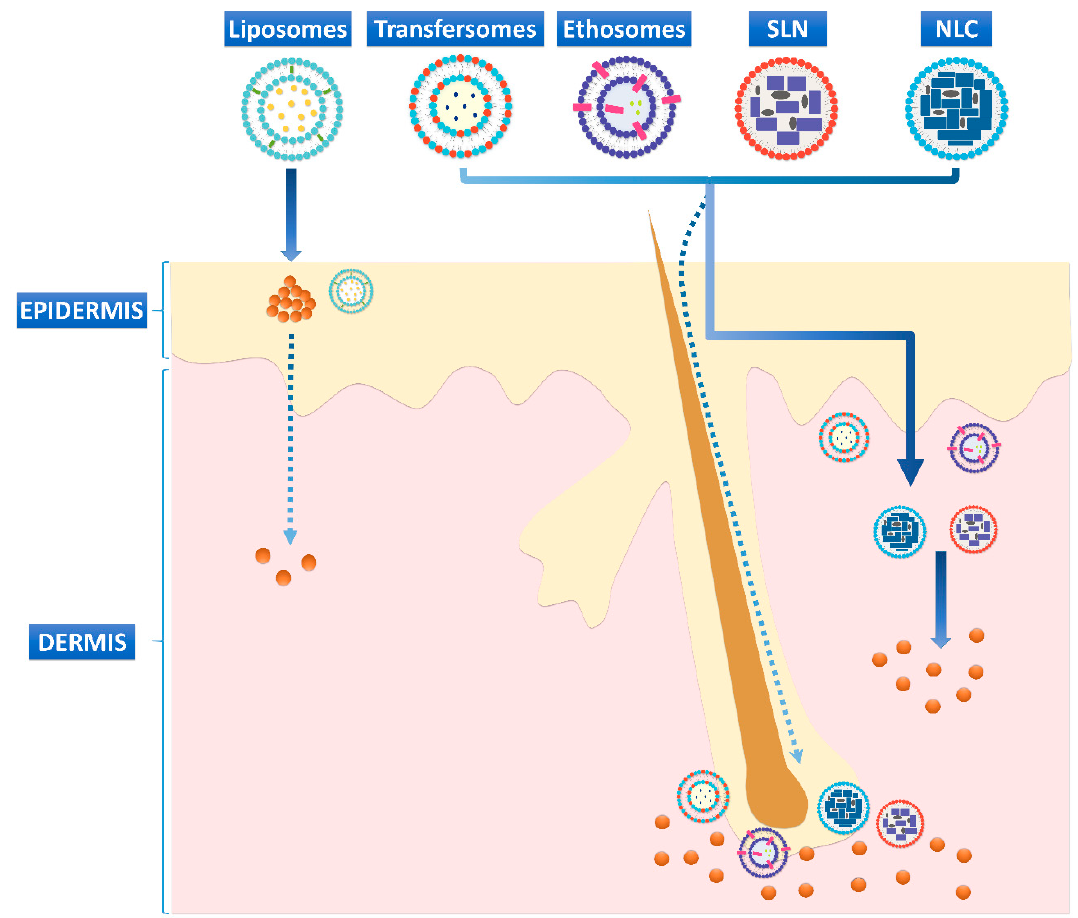
Figure 3. Schematic illustration of the anatomical target sites and skin penetration pathways of the nanosized-lipid-based drug delivery systems. Liposomes penetrate as an intracellular delivery system and deposit the drugs into the stratum corneum. They have poor penetration of the drug into the dermis. Transfersomes squeeze through the intercellular parts of the corneous layer or penetrate through the transfollicular pathway to release the drug into the dermis. Ethosomes penetrate stratum corneum lipids through fluidization, using transfollicular or intercellular pathways and releasing the drug into the dermis. Nanostructured lipid carriers (NLCs) and solid lipid nanoparticles (SLNs) penetrate through intercellular and transfollicular pathways into the dermis .